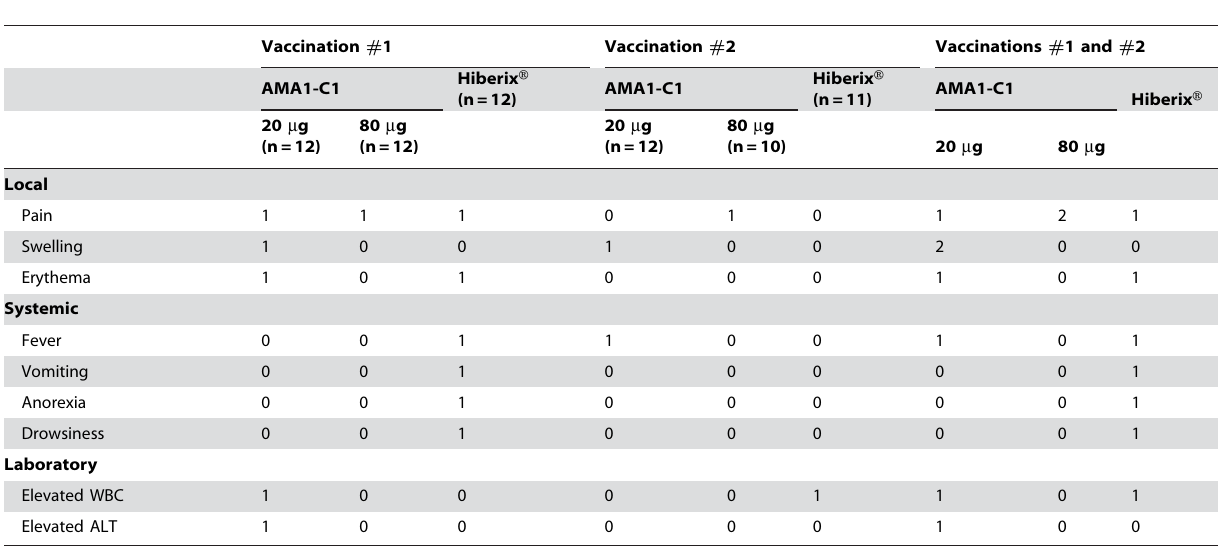
Table 1. Local injection site, systemic and laboratory adverse events judged definitely, probably, or possibly related to vaccine after vaccination with the AMA1-C1/Alhydrogel H or Hiberix H